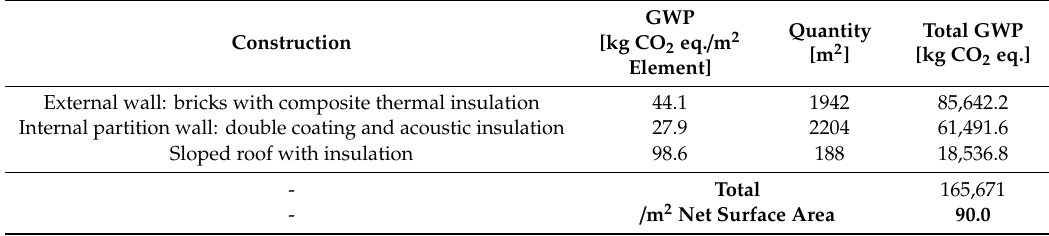
Table 2. Replacement measure specification (Source: Generis